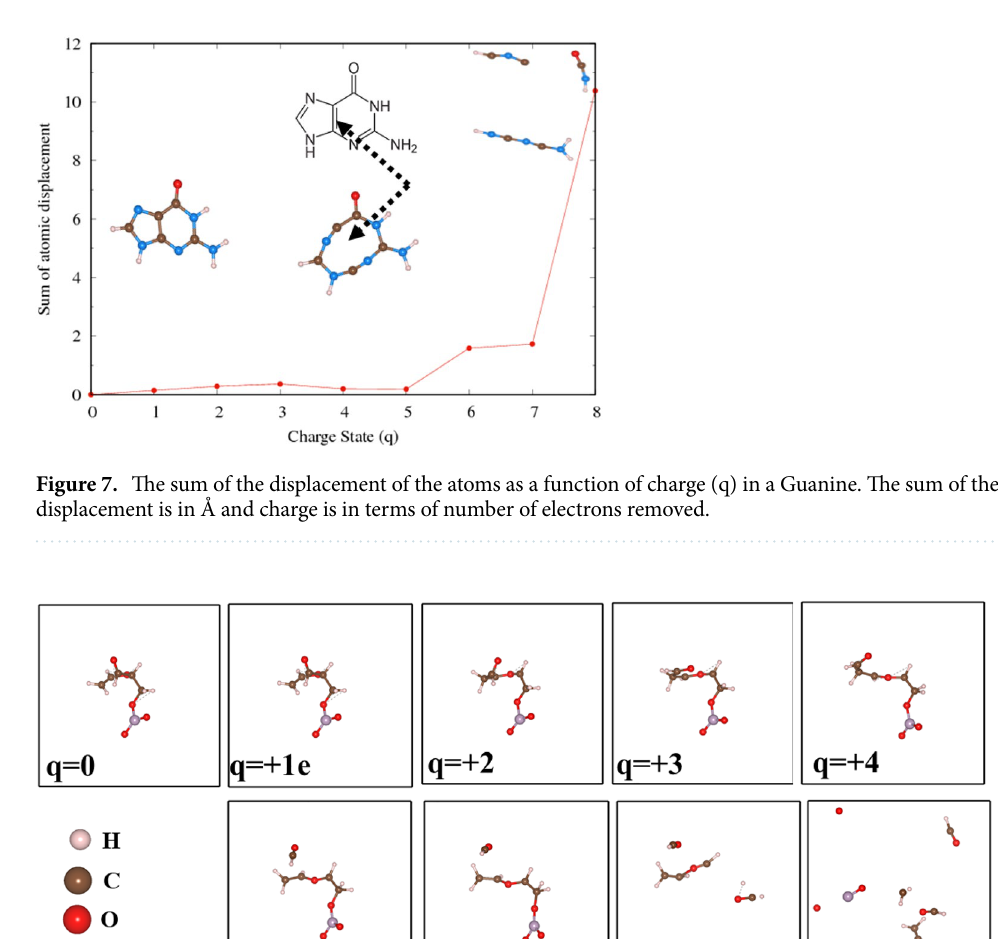
Figure 6. The effect of electron removal in Guanine molecule.